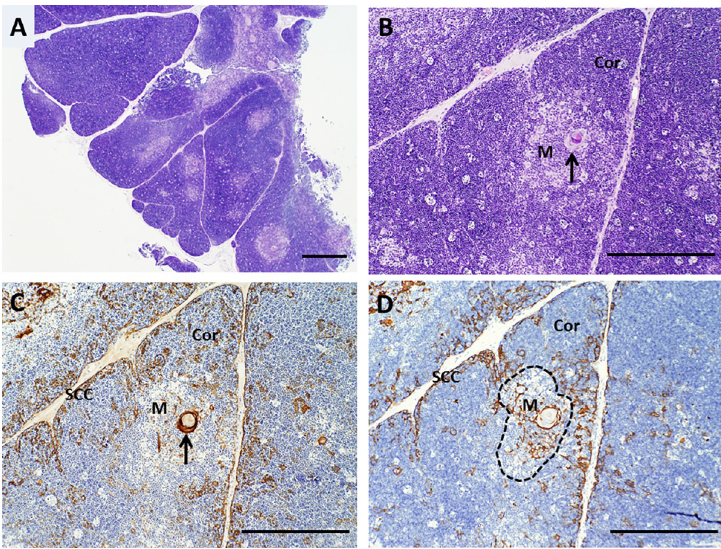
Fig 1. Architecture of cultured thymus, day 0. A, B. Hematoxylin and eosin (H&E) staining shows well-defined cortical and lighter-staining medullary areas, as expected for normal pediatric thymus. C. Immunohistochemistry with a cocktail of antibodies (AE1/AE3) that together detect all types of epithelial cells demonstrates that thymic epithelial cells are present beneath the capsule and in a light lacy network in both cortex and medulla. Arrows in B and C point to a Hassall body. D. Cytokeratin 14 (CK14) antibody reacts with thymic epithelial cells in the sub-capsular cortex and in the medulla, as well as with scattered thymic epithelial cells in the cortex. The dotted line highlights an area of medulla that is surrounded by cortex. Brown color indicates a positive reaction with antibody. SCC denotes sub- capsular cortex, Cor denotes cortex, and M denotes medulla. Bar represents 1 mm in A and 500 μ m in B–D.